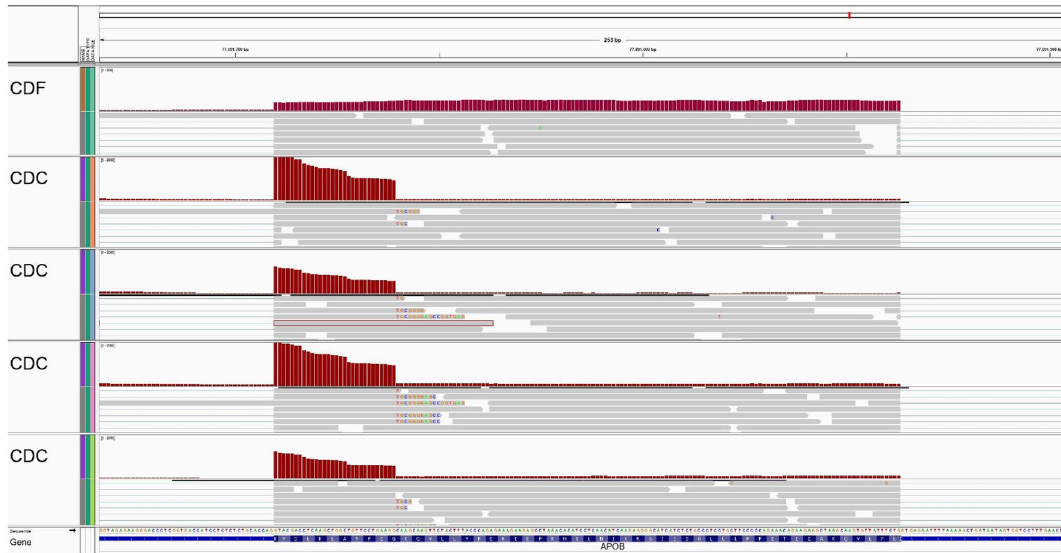
Figure 3. Integrative Genomics Viewer screenshot of APOB exon 5 liver expression profiles. At the top an unaffected CDF animal, below four CDC cows (note the different y-axis scales).